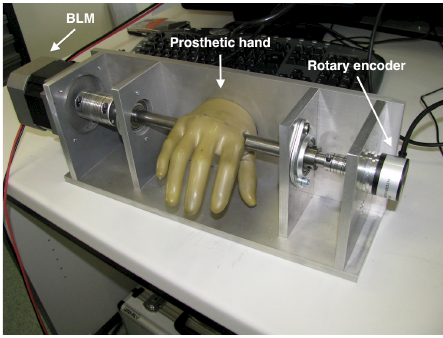
Figure 2. The prosthetic-hand master device.